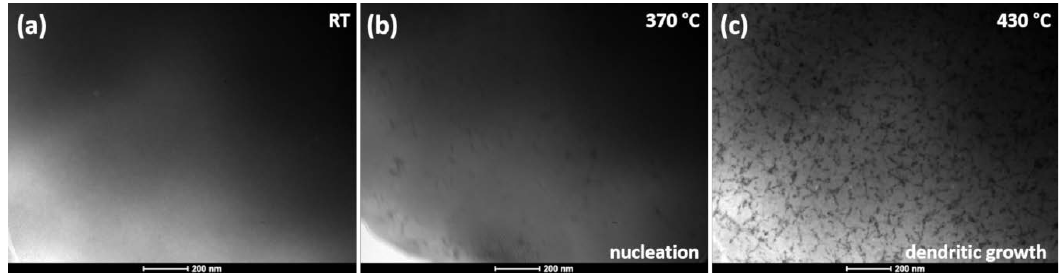
Figure 4. Set of BF microstructures recorded for the samples in-situ heated at 200 °C/min.